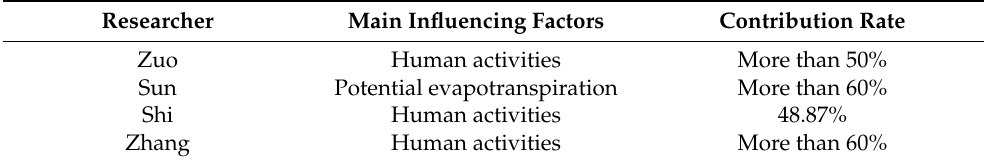
Table 1. Past studies in Weihe River